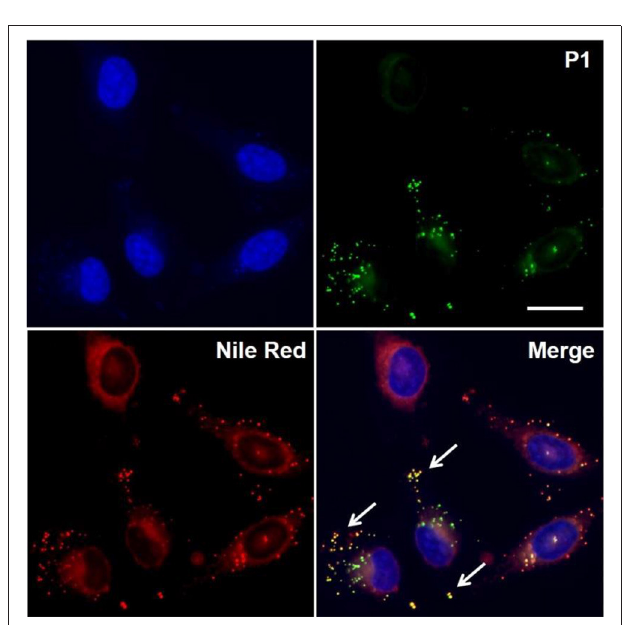
FIGURE 4 | High magnification fluorescence microscopy images of HeLa cells incubated with compound P1 (10 µ M, green), Nile red (10 µ M, red) and Hoechst 33342 (blue). Overlaid images indicate co-localization of P1 and Nile Red in intracellular LDs as shown by punctate yellow signals (white arrows). Scale bar: 10 µ